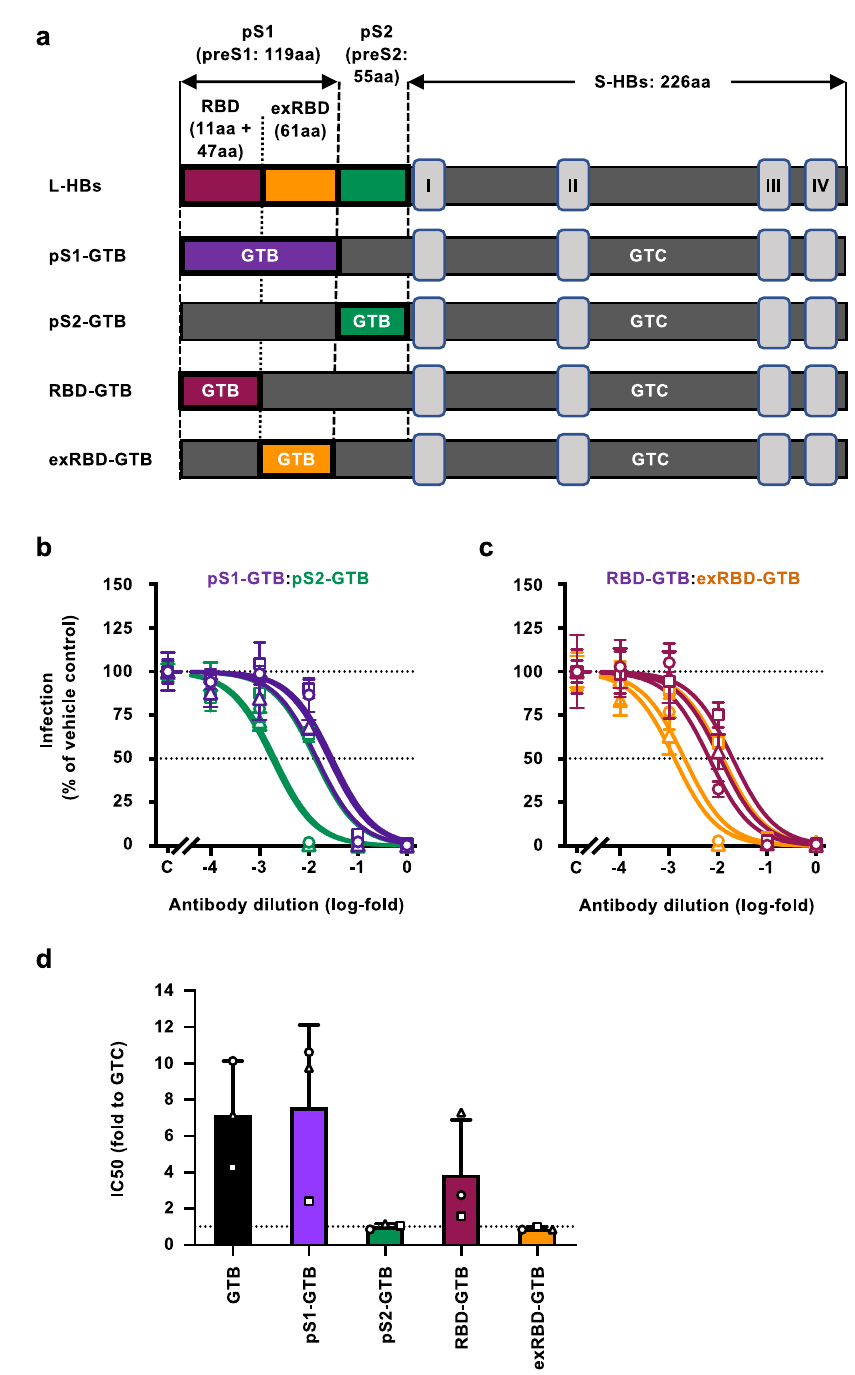
Fig. 6 | Region responsible for attenuated neutralizing activities against GTB. a The schema of the structure of L-HBsAg and chimeric HBV/NL constructs. The number of amino acids included in regions of L-HBsAg is indicated, and trans- membrane segments in S-HBsAg are labeled with roman numbers. b The neu- tralizingactivitiesofL-HBs+Addavax-inducedantibodiestoHBV/NLwithpreS1and preS2 of GTB were evaluated. The HBV/NLs harboring the preS1 (purple) or preS2 (green) region of GTB were mixed with serially diluted antibodies of rhesus macaques immunized with L-HBs+Addavax for 1h at 37°C and used to infect G2/ NT18-Ccells.Theinfectionef fi ciencieswereassessedbymeasuringtheNLactivities ofinfectedcellsin5wells7daysafterinfection. c Theneutralizingactivitiesagainst